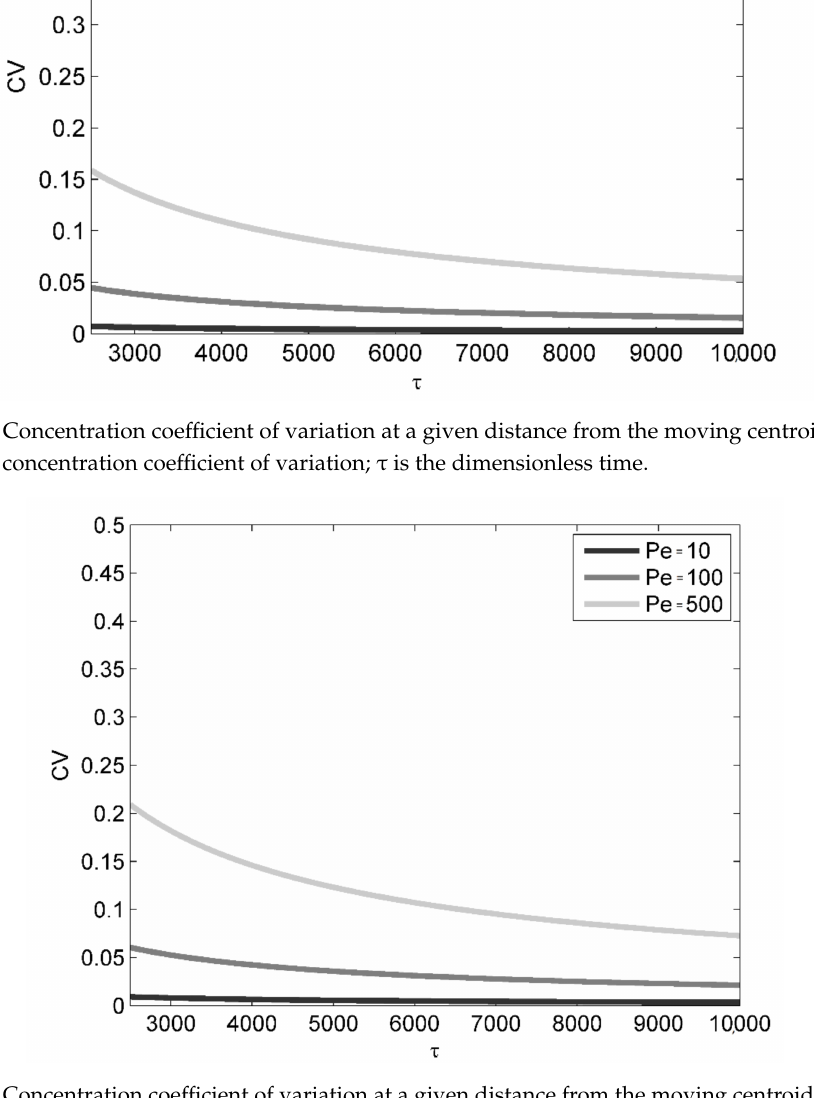
Figure 2. Concentration coe ffi cient of variation at a given distance from the moving centroid σ 2 CV is the concentration coe ffi cient of variation; τ is the dimensionless